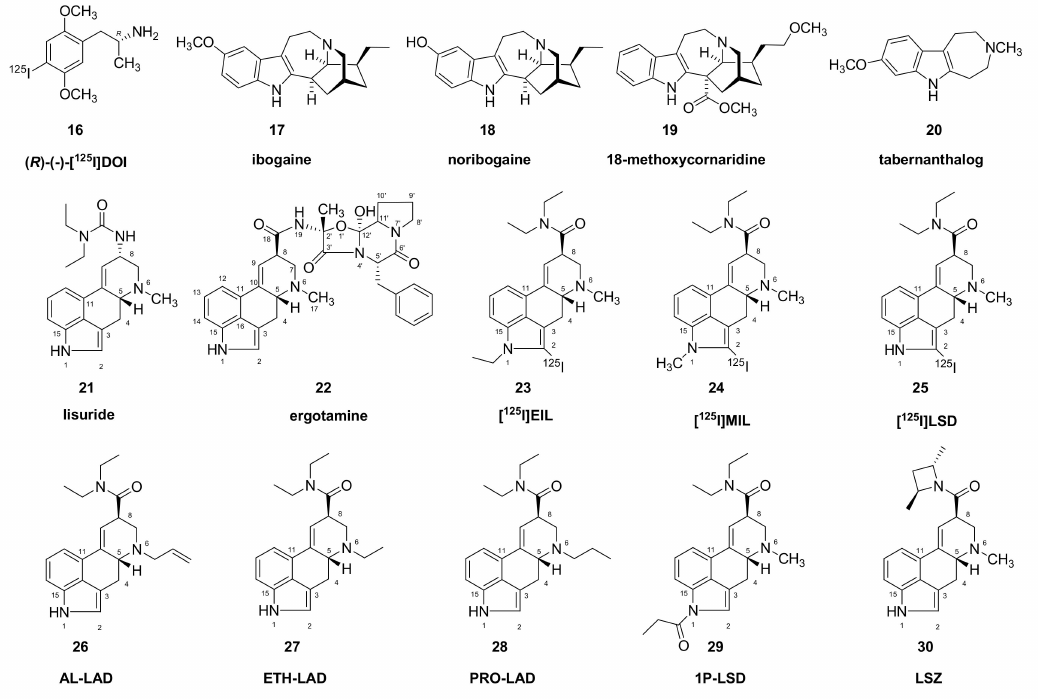
Figure 2. Structure of selected ibogaine and lisuride